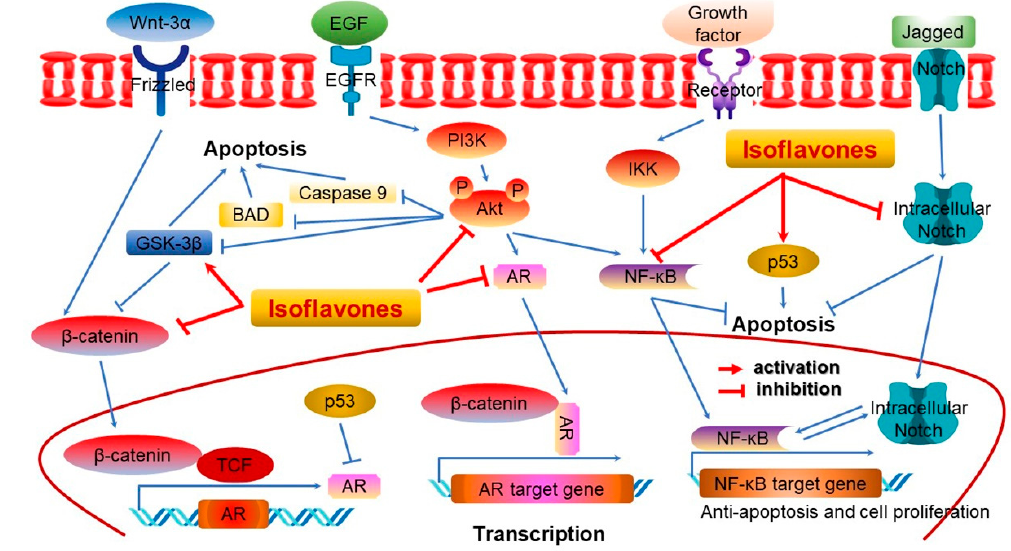
Figure 5. Schematic of multiple signaling pathways involved in isoflavone-induced cancer cell death [30]. Wnt-3 α , a protein of the Wnt family, plays critical roles in regulating pleiotropic cellular functions [30]. AR, androgen receptor; Akt, a serine/threonine-specific protein kinase known as a protein kinase B; BAD, Bcl2-associated agonist of cell death; GSK-3 β , glycogen synthase kinase 3 beta; EGF, epidermal growth factor; EGFR, epidermal growth factor receptor; TCF, T-cell specific transcription factor; IKK, I κ B kinase; p53, tumor protein-53; β -catenin, a core component of the cadherin protein complex; PI3K, phosphatidylinositol-3-kinase; NF- κ B, nuclear factor kappa light- chain-enhancer of activated B cells; Notch, a family of type-1 transmembrane proteins; → , activation; ⊥ , inactivation. Figure adapted from Li, Y. et al. [30].